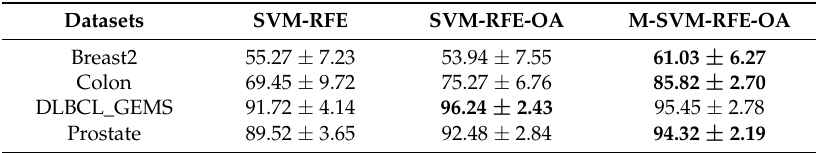
Table 4. Comparison in specificity